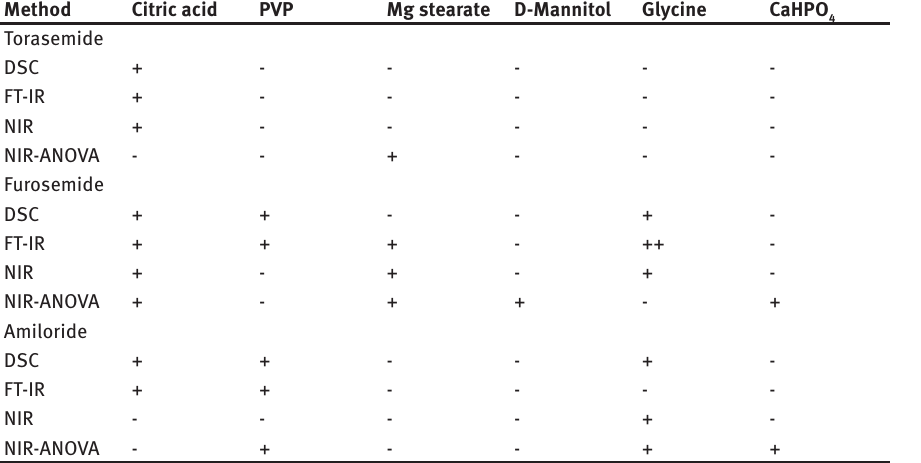
Table 1 : Differences between the stressed and the untreated binary mixtures of torasemide, furosemide and amiloride with operative excipients.